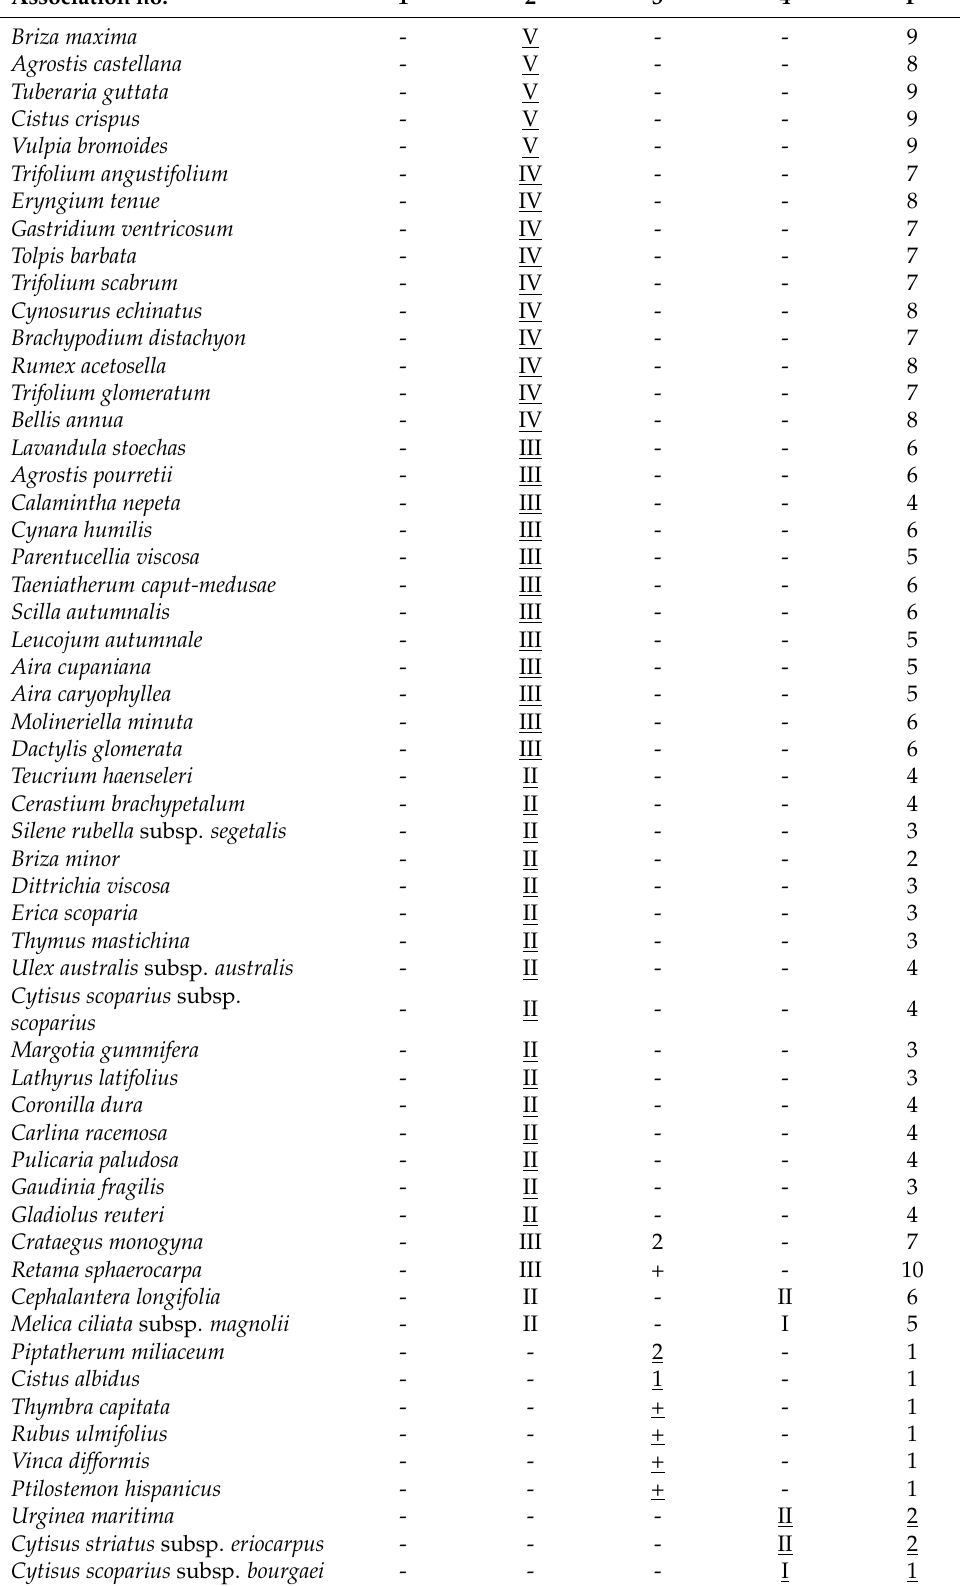
Table A1. Cont. Association